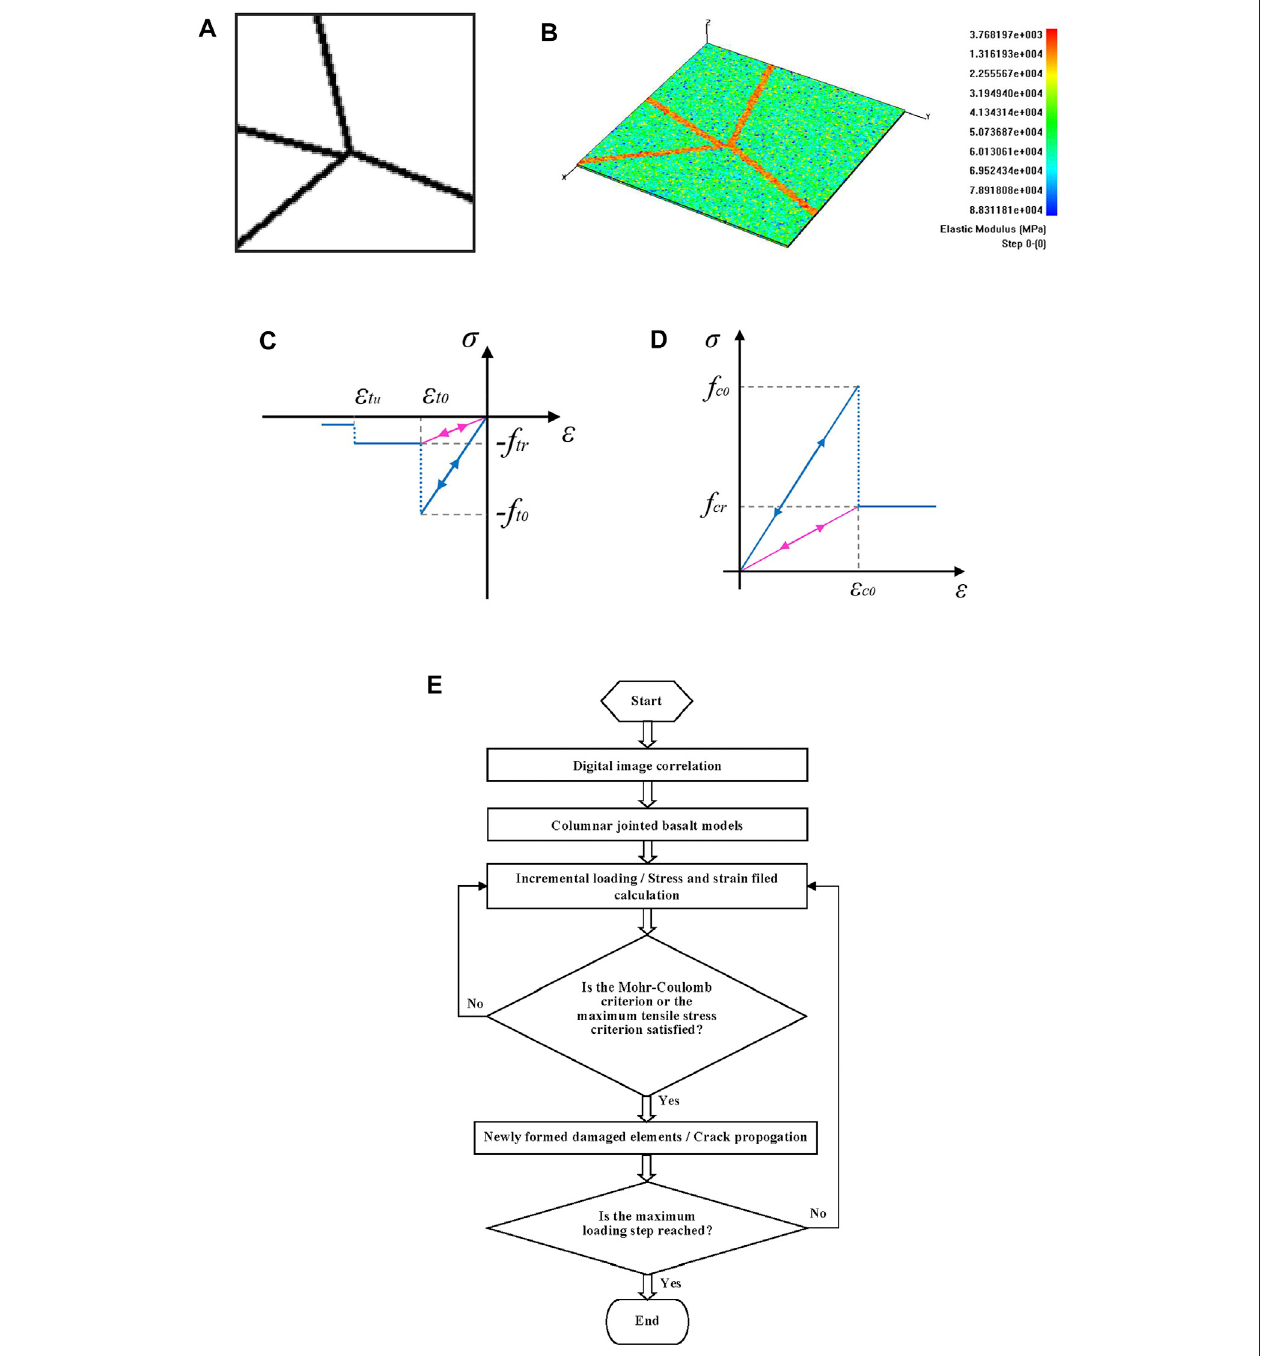
FIGURE 2 | The digital image (A) , the fi nite element model after digital image transformation (B) , the tensile state of an element under uniaxial stress (C) , the compressive state of an element under uniaxial stress (D) , and the calculation fl ow diagram of the digital image correlation (DIC)-improved rock failure process analysis (RFPA) method (E)